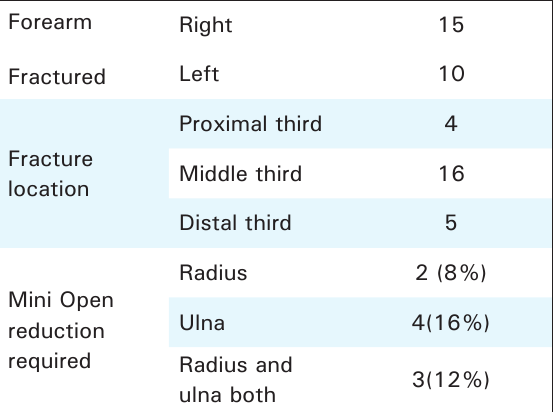
table 3. Fracture pattern and type of reduction.